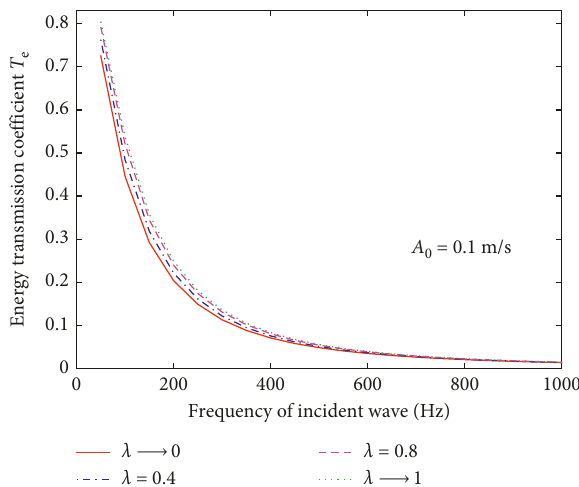
Figure 6: Effect of frequency on the energy transmission coefficient with different λ values.